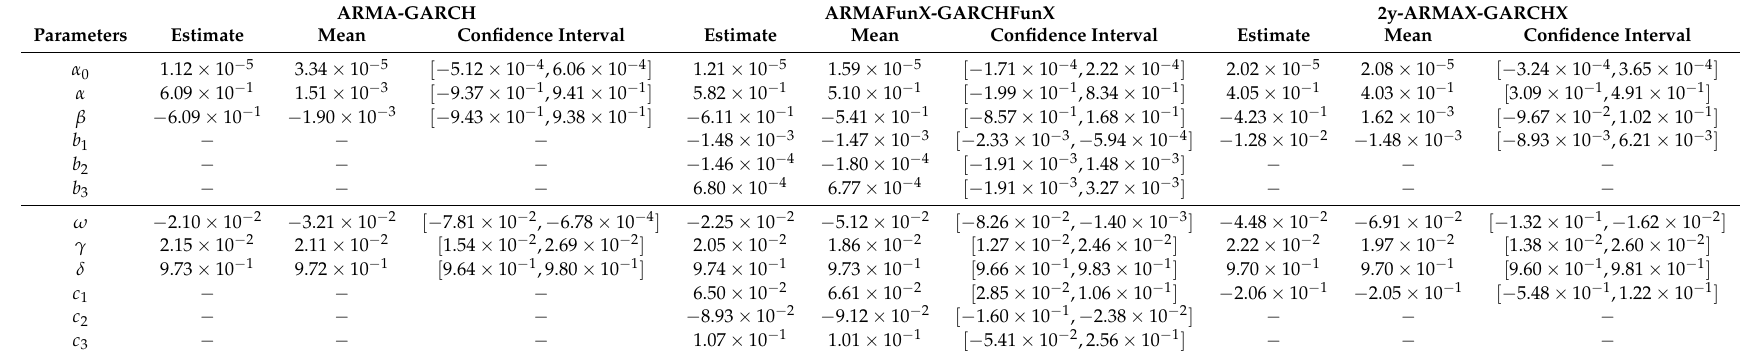
Table 1. Parameter estimates, bootstrapped means and bootstrapped 95%-confidence intervals using 10,000 simulated paths of length 2903.